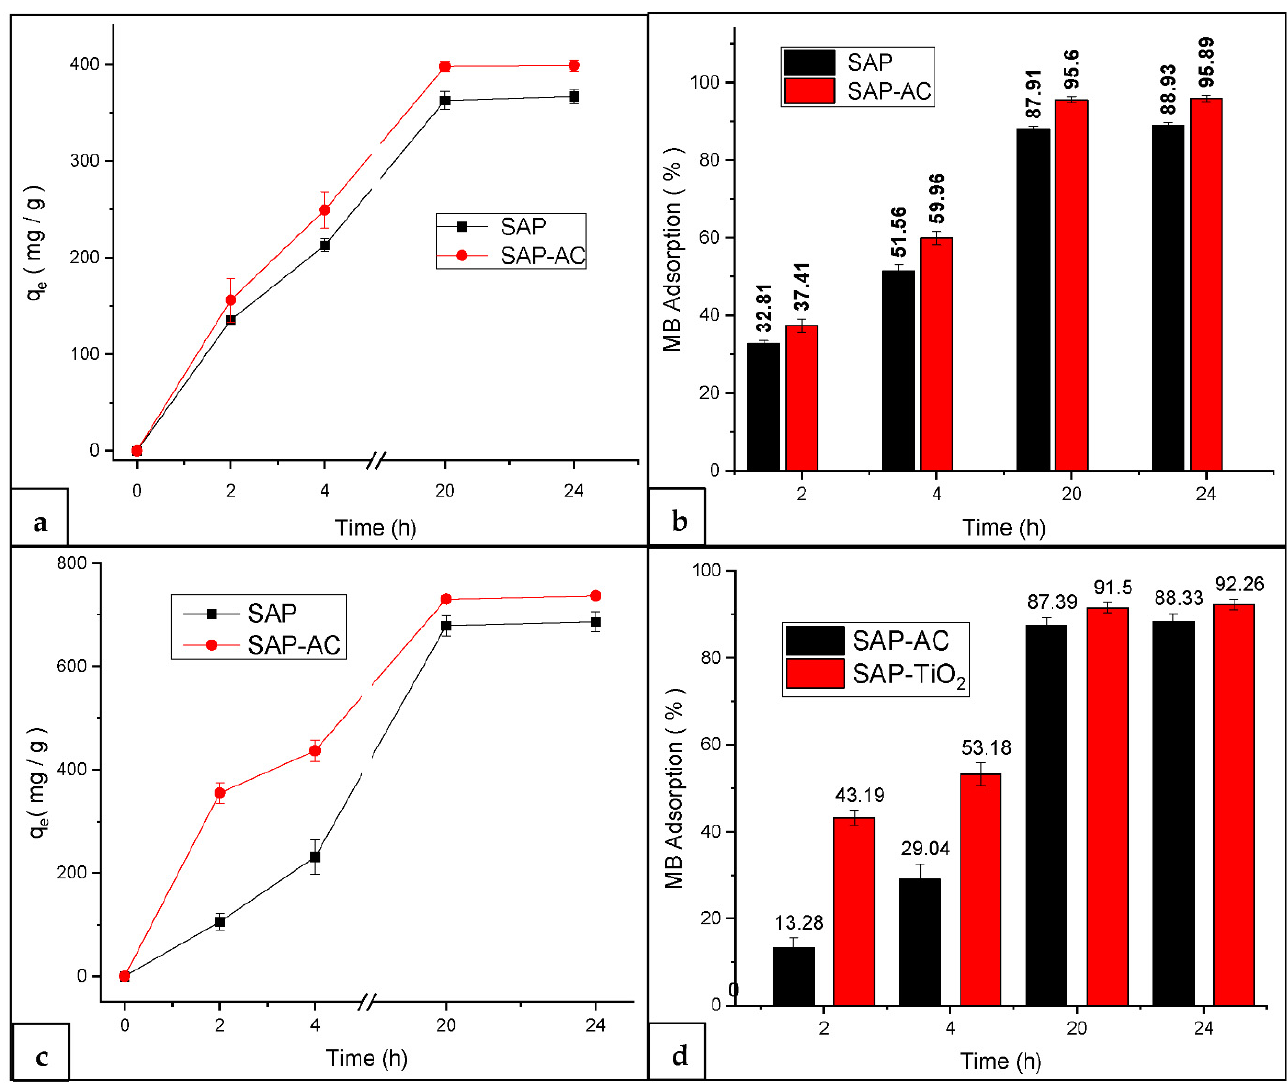
Figure 11. MB adsorption as a function of time. ( a ) Adsorption capacity and ( b ) percent adsorption using 100 ppm, and ( c ) adsorption capacity and ( d ) percent adsorption using 200 ppm initial concentration.